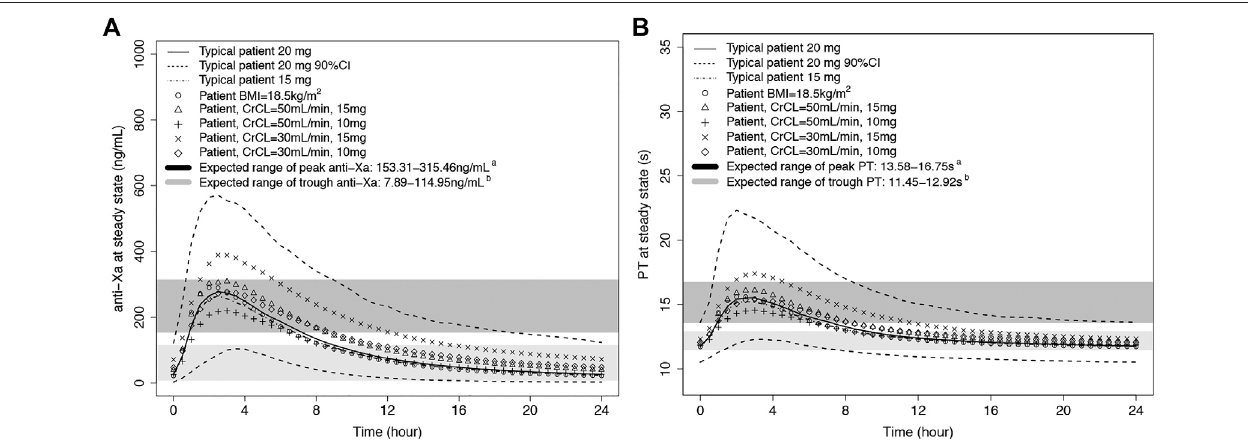
FIGURE 4| Predicted rivaroxaban PD-timepro fi les. A : anti-Xa-time pro fi le; B : PT-time pro fi le. The typical patient has mean characteristics (BMI = 24.7 kg/m 2 , WT =68 kg,TCHO=3.81 mmoL/L,CrCL=75.4 ml/min). A :Theexpectedrangesofpeakanti-XaorPTwerecalculatedfromtheexpectedplasmapeaklevelofrivaroxaban in NVAF patients (Steffel et al., 2021) by the integrated PK/PD model in our study. B : The expected ranges of trough anti-Xa or PT were calculated from the expected plasma trough level of rivaroxaban in NVAF patients (Steffel et al., 2021) by the integrated PK/PD model in our study.